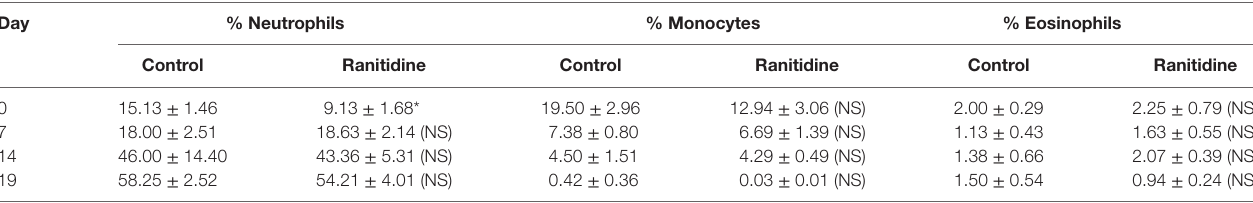
TaBle 1 | Percent of neutrophils, monocytes, and eosinophils of live leukocytes in circulation in 4T1 tumor-bearing BALB/c mice. Day % neutrophils % Monocytes % eosinophils control ranitidine control ranitidine control